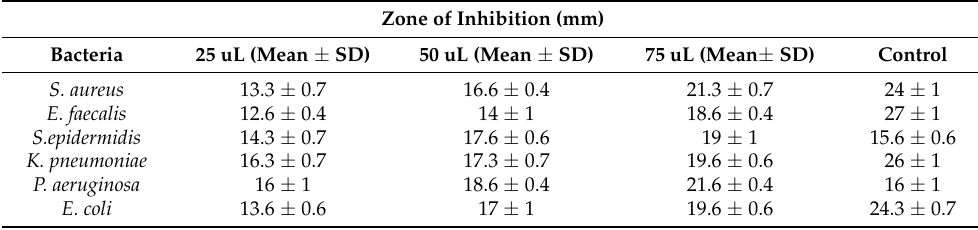
Figure 8. ZOI ( a ) control groups (DMSO, UD extract, and AgNO 3 ) and ( b ) synthesized UD-AgNPs against S. aureus , E. faecalis , S. epidermidis , E. coli , K. pneumoniae , and P. aeruginosa . Table 1. The zone of inhibition observed for different bacterial isolates and different amounts of